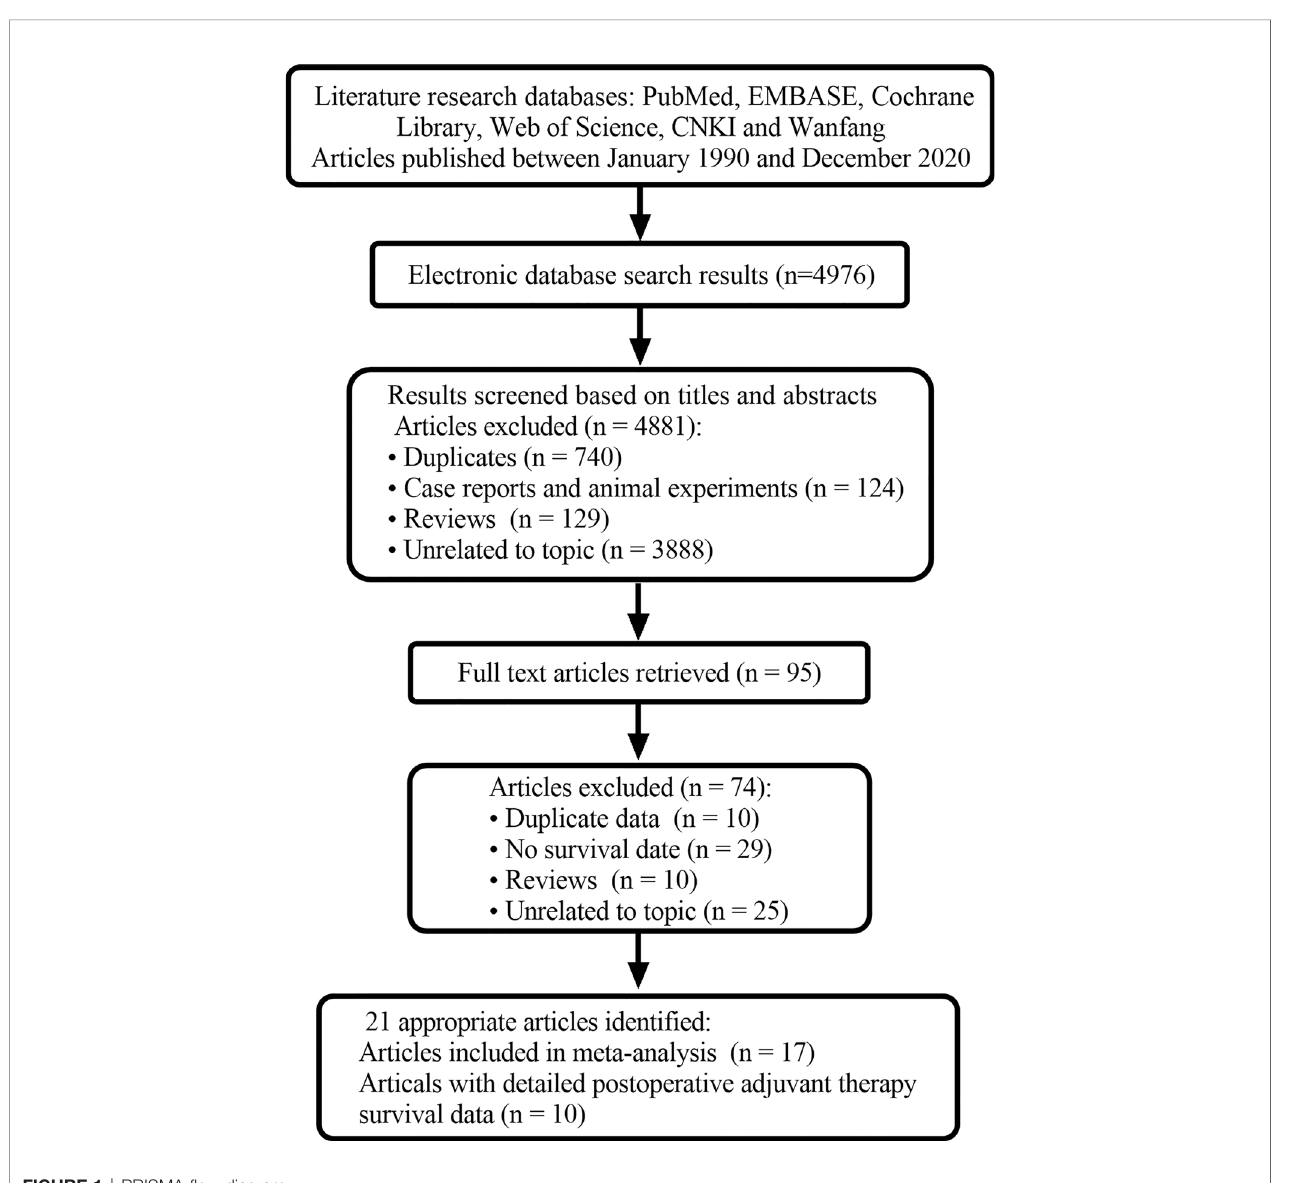
FIGURE 1 | PRISMA fl ow